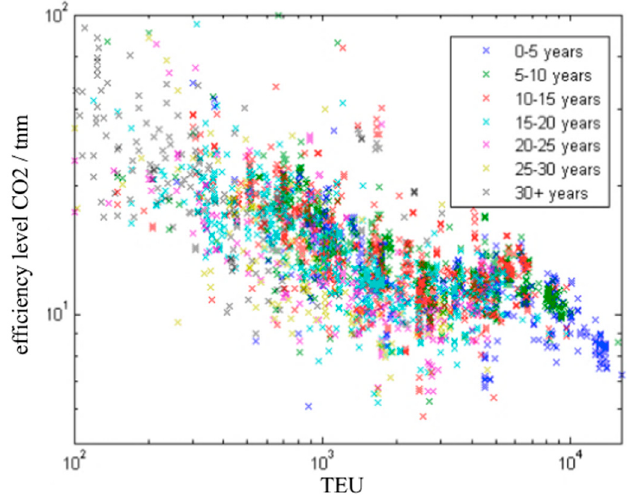
Figure 7. Container ship size correlated with emitted CO 2 (i.e., efficiency level gCO 2 /tnm) per unit of transport work against TEU capacity, according to vessel age, adapted from Smith et al. [51].